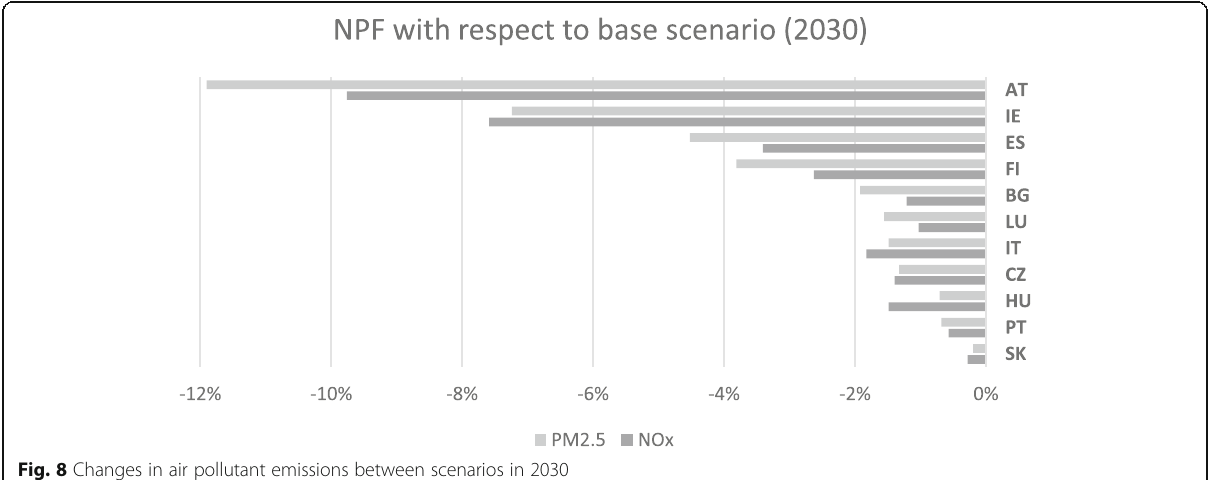
Fig. 8 Changes in air pollutant emissions between scenarios in